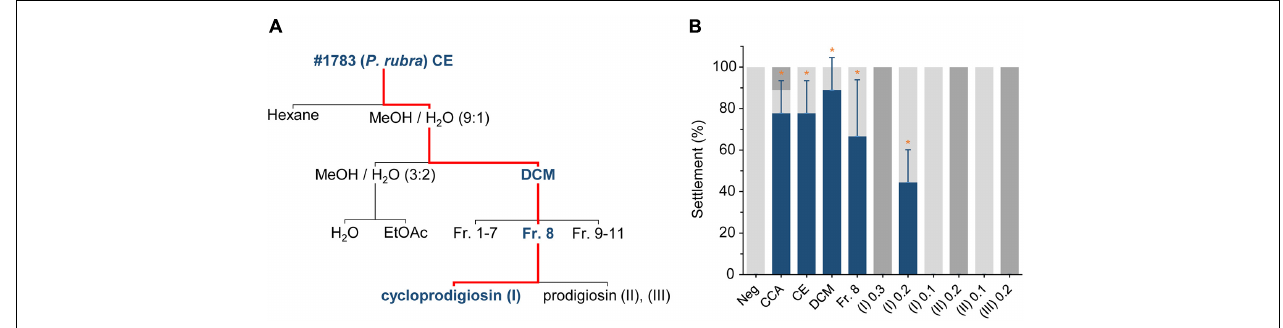
FIGURE 1 | Extraction of settlement cues from Pseudoalteromonas rubra #1783 and initial evaluations of their settlement-inducing activity toward Leptastrea purpurea coral larvae. (A) Flow scheme of secondary metabolite extraction from Pseudoalteromonas rubra #1783. The bold blue font as well as the red line follows the path of settlement-inducing activity within each crude extract/fraction/compound. (B) Response of Leptastrea purpurea larvae after 48 h to different fractions of #1783 under unregulated light conditions (see materials and methods section for details): CE, crude extract (10 µ g mL − 1 ), DCM, dichloromethane (5 µ g mL − 1 ), SPE, solid-phase extraction (C 18 -based, fraction 8) (0.5 µ g mL − 1 ), (I), cycloprodigiosin (0.1, 0.2, and 0.3 µ g mL − 1 ), (II), prodigiosin (0.1 and 0.2 µ g mL − 1 ), (III), 2-methyl-3-hexyl prodiginine (0.2 µ g mL − 1 ). Percentages of swimming larvae are displayed in light gray, settlement in dark blue, and dead/disintegrated larvae in dark gray. Evaporated MeOH and 5 mL of filtered artificial seawater (FASW) served as negative control (Neg). Small pieces of live CCA emerged in 5 mL of FASW were used as positive control. Error bars represent standard deviations of settlement. Asterisks (*) represent significant settlement responses ( p < 0.05, n =